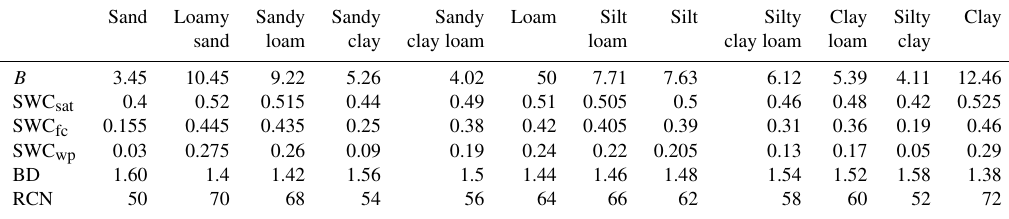
Table 2. Default values of parameters in BBGCMuSo for different soil types. Soil types are identified based on the user-defined sand, silt, and clay fraction of the soil layers based on the soil triangle method. Sand Loamy Sandy Sandy Sandy Loam Silt Silt Silty Clay Silty Clay sand loam clay clay loam loam clay loam loam clay